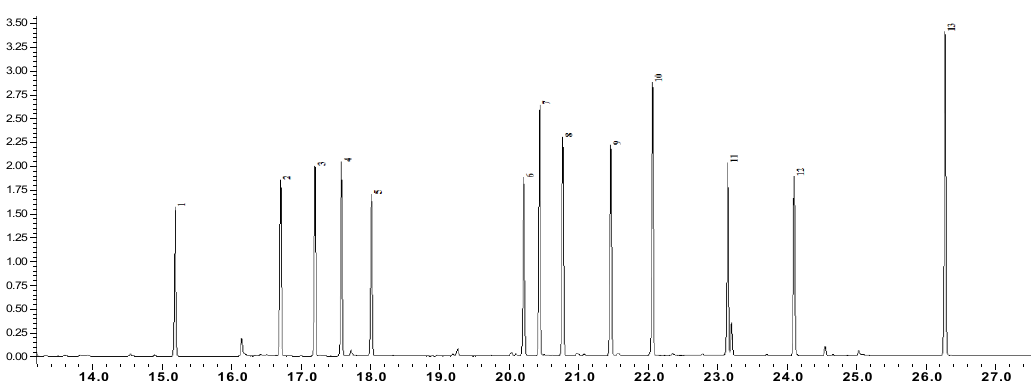
Figure 1. GC-MS chromatogram of amino acid standards mixture: 1) L-Alanine; 2) L-Valine; 3) L-Leucine; 4) Isoleucine; 5) L-Proline; 6) L-Methionine; 7) L-Serine; 8) L-Threonine; 9) L-Phenylalanine; 10) L-Aspartic acid; 11) L-Glutamic acid; 12) L-Lysine; 13) L-Tyrosine.